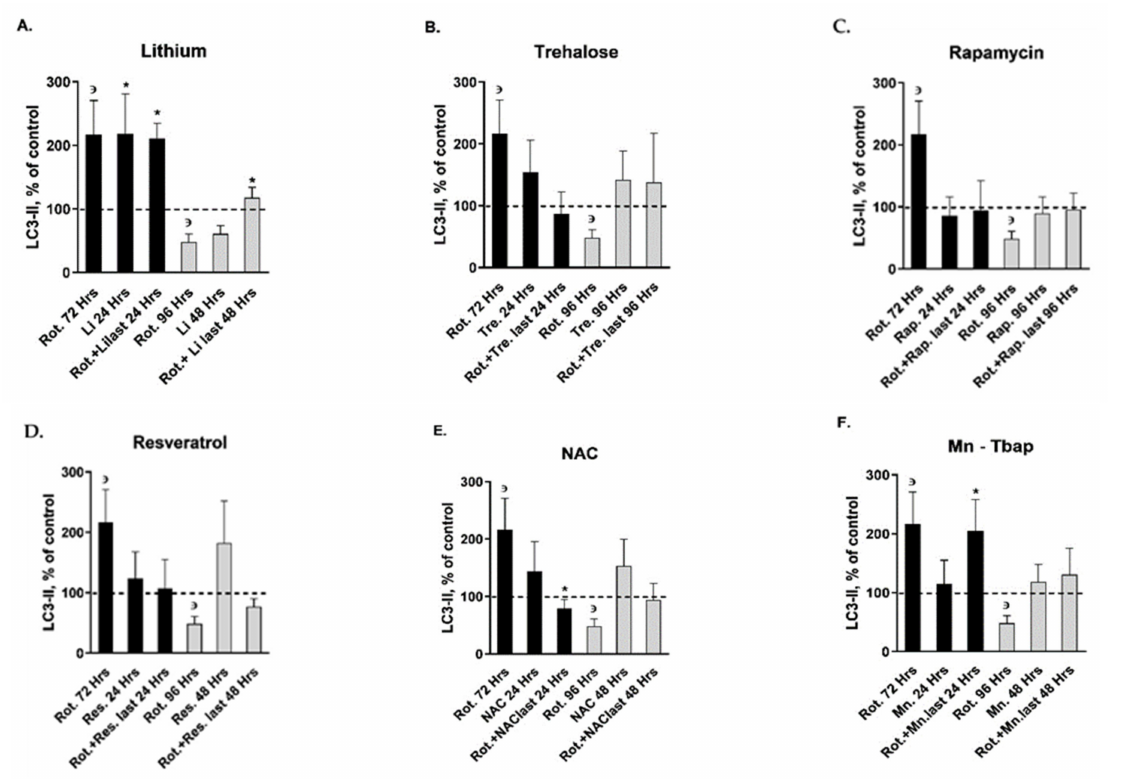
Figure 4. Effect of autophagy enhancers/ROS scavengers on LC3-II protein levels pre and post exposure to 10 pM rotenone Results represent means ± S.E.M. of four independent experiments, each in duplicate. Rot. = rotenone; Li = lithium; Tre. = trehalose; Rap. = rapamycin; Res. = resveratrol; NAC = N-acetylcysteine; Mn. = Mn-Tbap. з Rot. for 72/96 h vs. control, p = 0.05—as previously described [23] and confirmed now. One sample of each of rotenone’s effect, NAC’s effect and Mn-Tbap’s effect for 72 h exceeding mean ± 2SD was omitted. A. Lithium effects, Two-way ANOVA: Treatment— F 3,25 = 3.02, p = 0.04; duration—F 1,25 = 42.7, p = 0.00001; TreatmentXDuration interaction—F 3,25 = 7.6, p = 0.0008; *Fisher’s LSD post-hoc test: 24 h of Li vs. control, p < 0.00002; Rot. for 72 h + Li. last 24 h vs. control, p = 0.008; Rot. for 96 h + Li. last 48 h vs. Rot. for 96 h, p = 0.05. B. Trehalose effects, Two-way ANOVA: TreatmentXDuration interaction—F 3,26 = 2.5, p = 0.07. C. Rapamycin effects, Two-way ANOVA: TreatmentXDuration interaction—F 3,26 = 4.2, p = 0.01. D. Resveratrol effects, Two- way ANOVA: TreatmentXDuration interaction—F 3,24 = 3.2, p = 0.03. E. NAC effects, Two-way ANOVA: